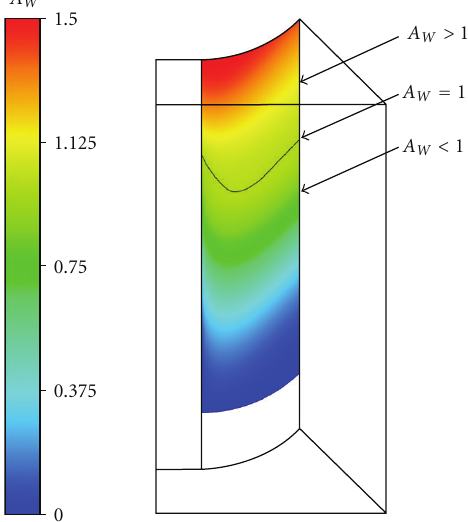
Figure 7: Distribution of the area fraction occupied by gas A W (7) on the heated wall for N ref = 8 × 10 5 m − 2 (compare Figure 4). Only 1/8 of the channel is simulated considering the geometric